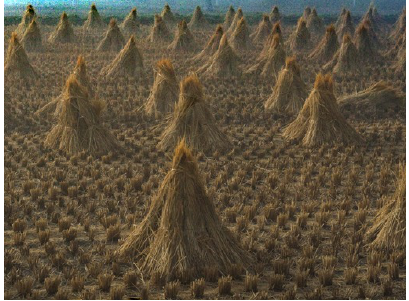
Figure 6. Weightless fusion of 21 radiances. A = [ A s − δ , A s + δ ] = [ 193 − 10, 193 + 10 ] = [ 183, 203 ]